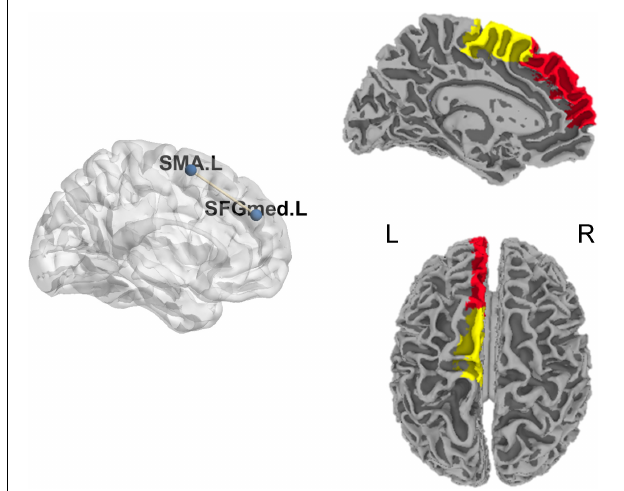
FIGURE 2 | Significant difference for DFC between chronic tinnitus patients before acupuncture and normal subjects. DFC, dynamic functional connectivity; L, left; R, right; SFGmed, superior frontal gyrus, medial part; SMA, supplementary motor area.